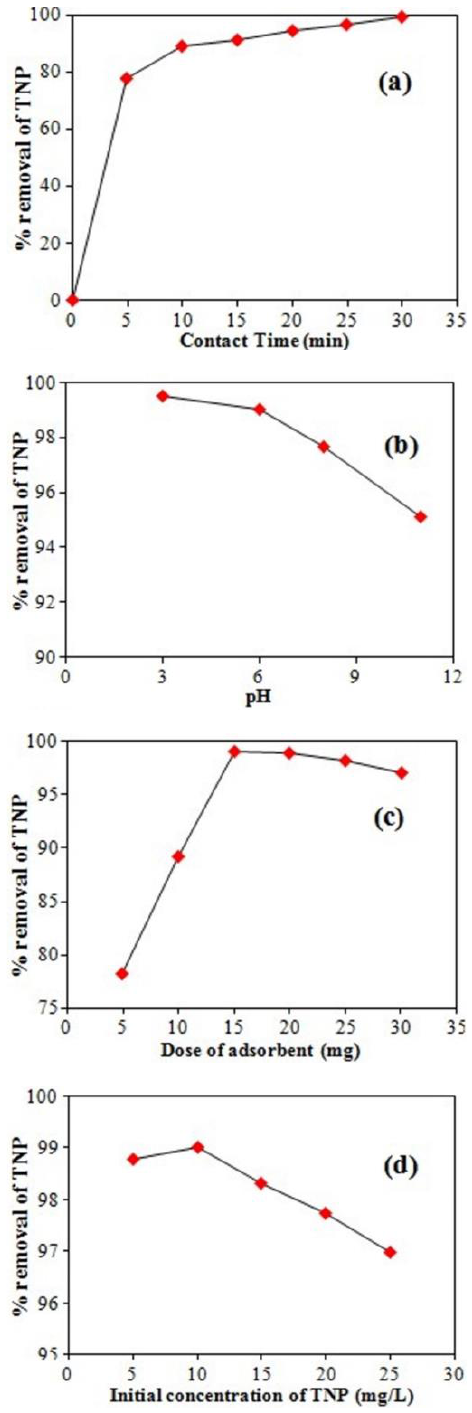
Figure 4. Effect of contact time (a), pH of solution (b), dose of adsorbent (c) and initial concentration of trinitrophenol (TNP) (d) on adsorption of trinitrophenol (TNP) onto PANI-